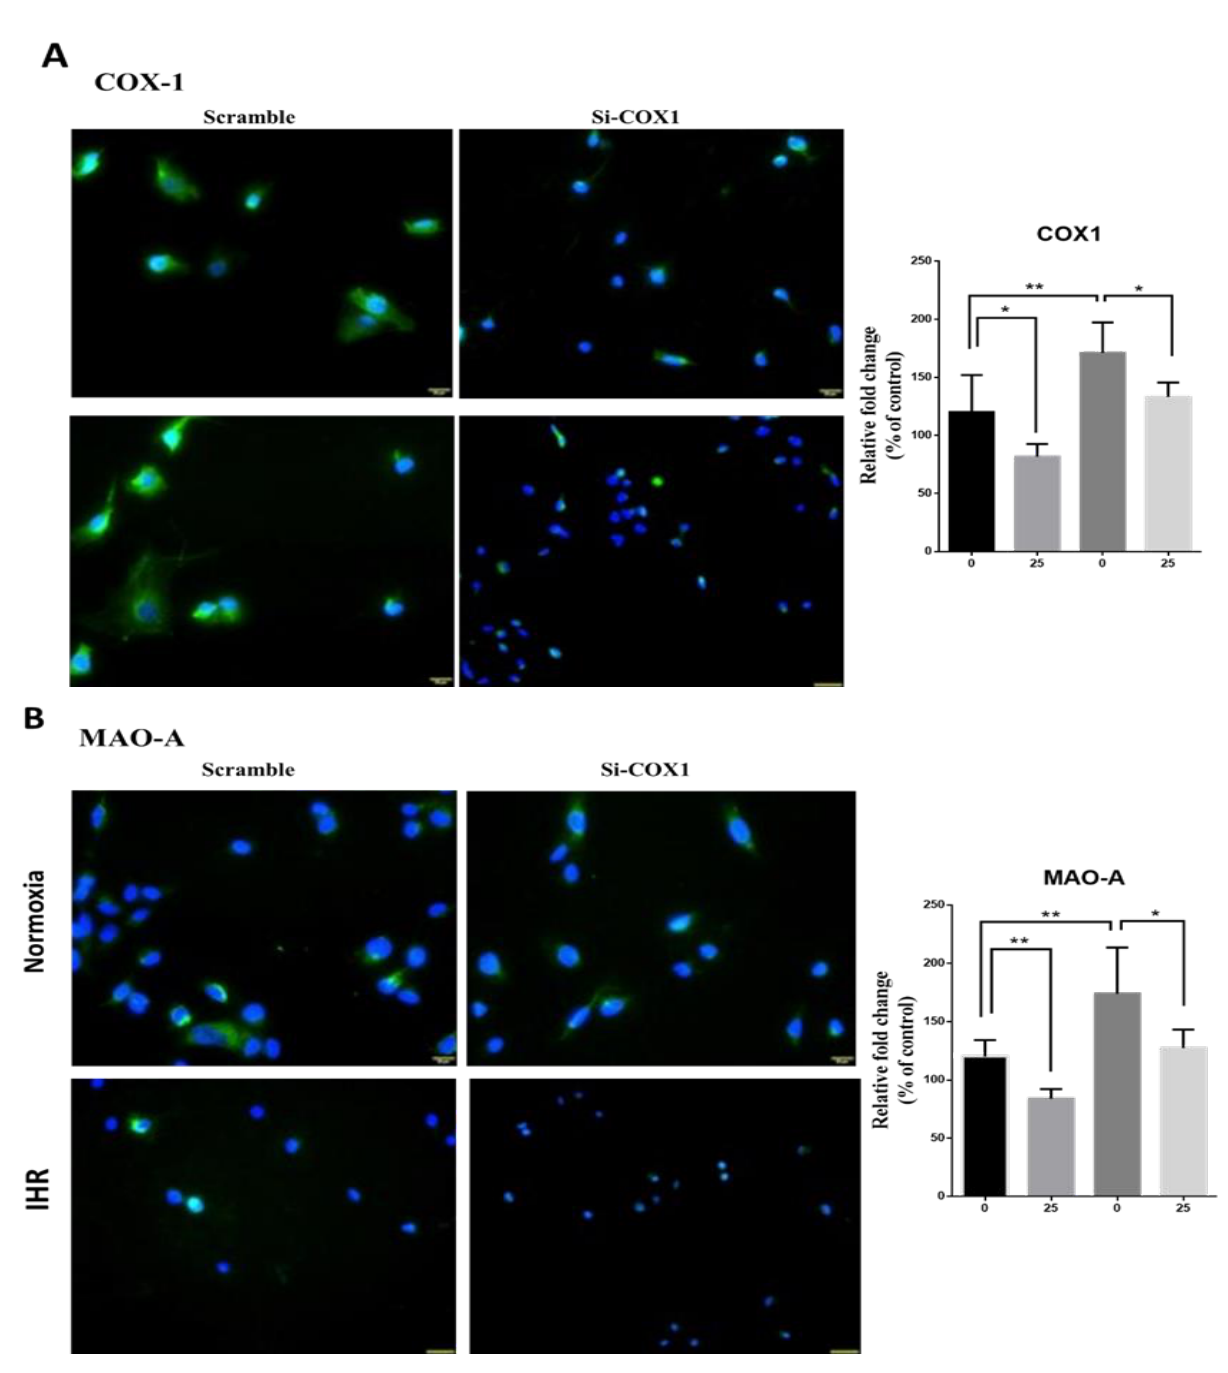
Figure 10. PTGS1 (COX1) knock-down reversed intermittent hypoxia with re-oxygenation (IHR)-induced up-regulation of MAOA hyperactivity. Representative micrographs of immunofluorescence staining in SH-SY5Y neuron cells with or without the knock-down of PTGS1 under IHR versus normoxic (NOX) conditions are given for ( A ) COX1, and ( B ) MAOA. IHR resulted in over-expressions of COX1, and MAOA hyperactivity, both of which were reversed with the knock-down of COX1. DAPI (blue) is used for staining the nuclei. Localizations of the two molecules are indicated in green. All the micrographs are a merge of the two stainings. Quantified values are stratified based on the response to IHR stimuli and PTGS1 SiRNA transfection. Kruskal – Wallis test with post-hoc analysis was used for comparisons between four groups. * p < 0.05. ** p < 0.01.